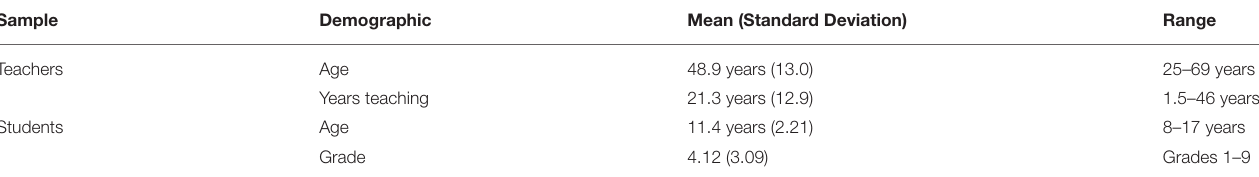
TABLE 1 | Student Demographics (as reported at study commencement).